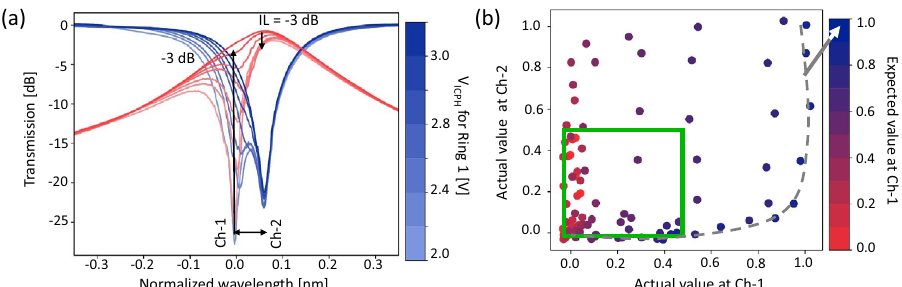
Figure 8. ( a ) Measured transmission spectra at through (blue) and drop (red) ports of Type-I systems, the X-axis represents the wavelength offset from the resonance wavelength of Ch-1. The linewidth-normalized channel spacing is set to 0.5. ( b ) Measured value ranges for Channel-1 and Channel-2. The green box shows the usable mapping range of [0, 0.5]. The colorbar interprets the expected value for